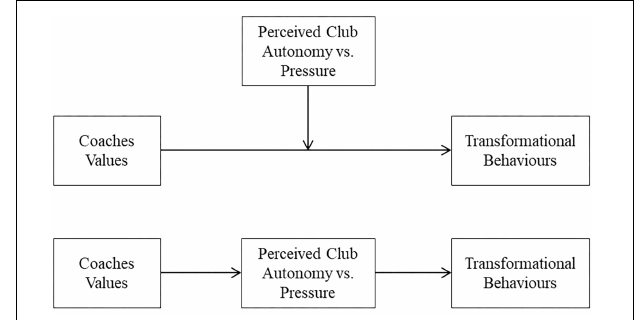
FIGURE 2 | Study model: Relationship between coach values and transformational behaviors, mediated vs. moderated by perception of autonomy vs. pressure at the